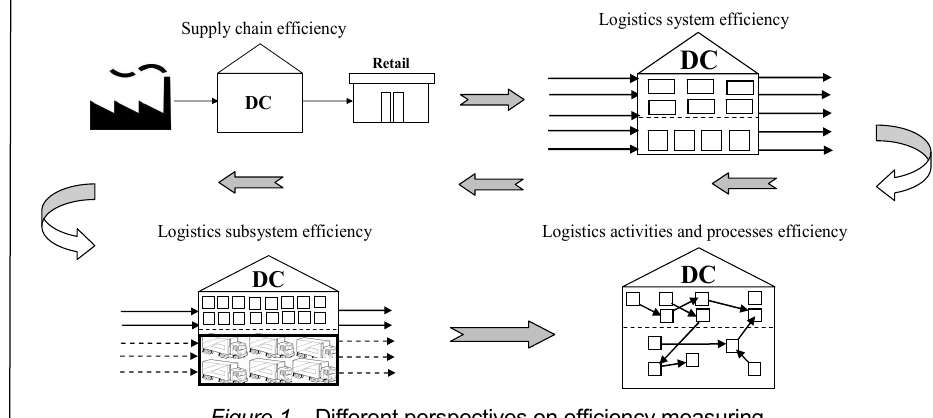
Figure 1 – Different perspectives on efficiency measuring Slika 1 – Razli č ite perspektive merenja